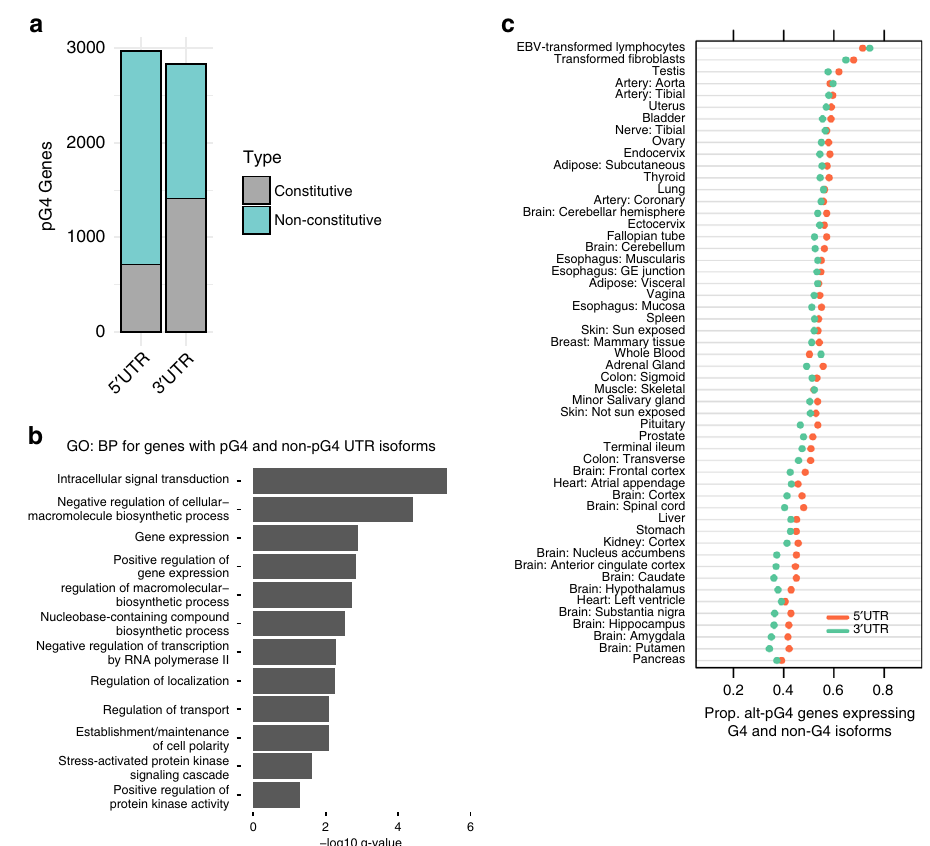
Fig. 2 Isoforms with G4 in UTR distribution and usage. a Most genes producing mRNA transcripts with UTR pG4 sequences also produce alternative isoforms that lack UTR pG4s (non-constitutive). b For the subset of genes that produce UTRs with alternative pG4 inclusion, both pG4-containing and non- pG4 isoforms are frequently expressed simultaneously. Median expression (TPM) of each pG4-transcript or non-pG4 transcript was assessed for each tissue context. Transcripts were considered as expressed if their median TPM measurement exceeded one TPM for each tissue context considered. The proportion of pG4 genes expressing both pG4 isoforms, and non-pG4 isoforms was then compared for each tissue. c Overrepresented biological processes for protein-coding genes producing both pG4 and non-pG4 5 ′ or 3 ′ UTR isoforms ( n = 3148) — see Supplementary Data 1 for the full list. GO-term enrichment was performed using PantherDB 55 and enrichment was determined by meeting a Benjamini – Hochberg adjusted P value cutoff of 0.05 by Fisher ’ s exact test. Source data are provided as a Source Data fi